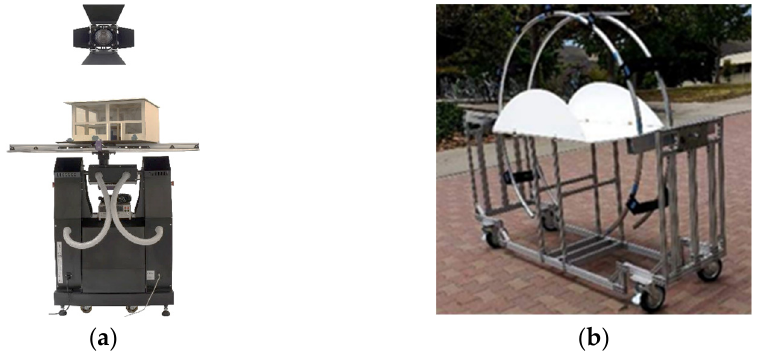
Figure 3. ( a ) Orange Heliodon, designed by Betanit company, and ( b ) Dolan’s heliodon.